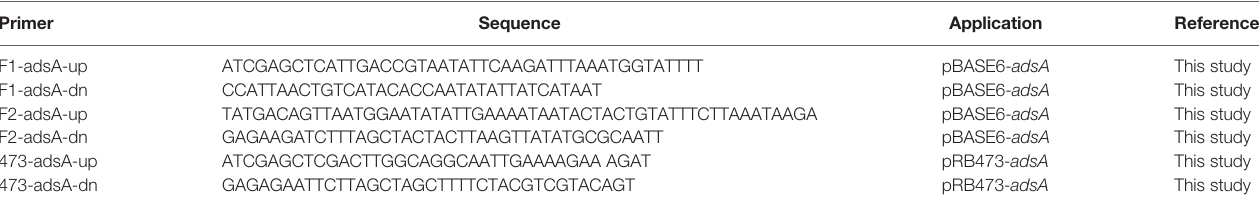
TABLE 2 | Oligonucleotides used to generate knock-out and complementation